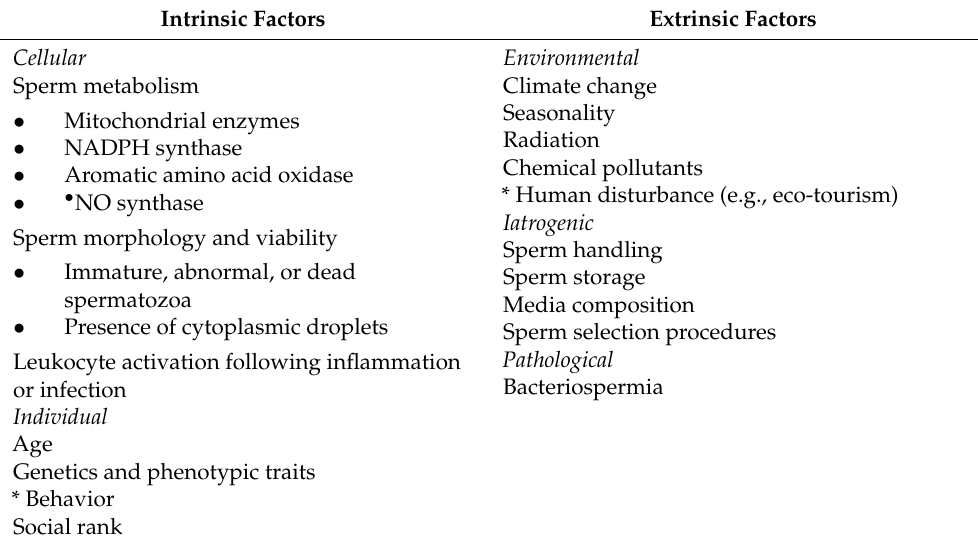
Table 1. Known and potential factors associated with oxidative stress in the male reproductive system of domestic and wild